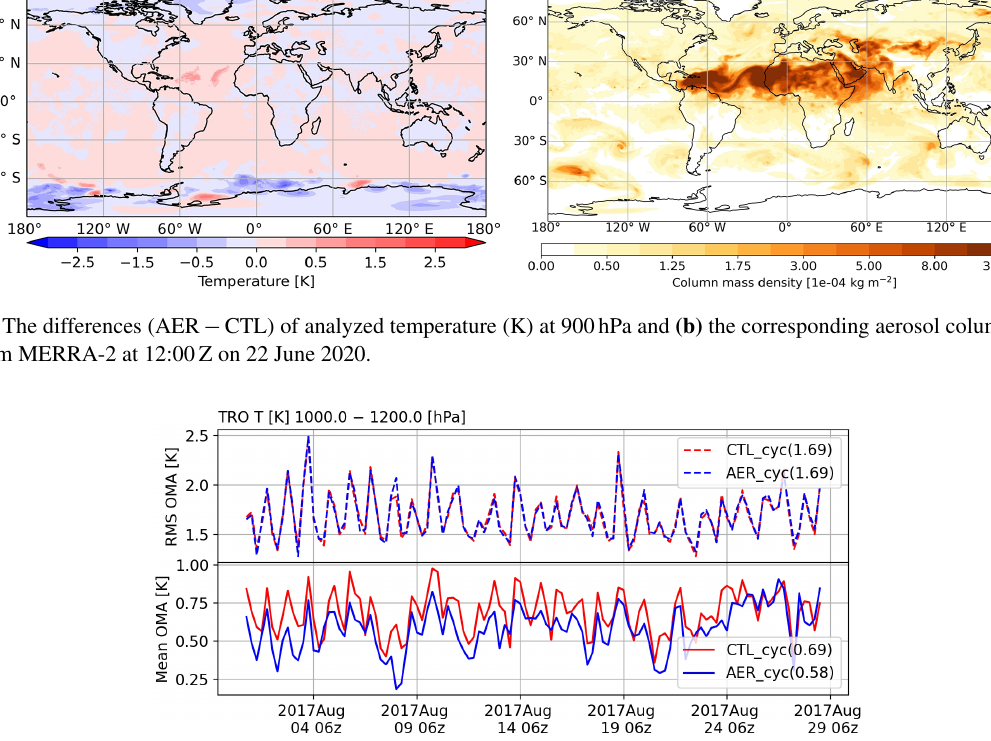
Figure 6. The comparison of the RMS and mean analysis departures (observation minus analysis, OMA) against in situ measurements (e.g., radiosonde) of temperature with pressure over 1000hPa at the tropical region (20 ◦ S–20 ◦ N) during 00:00Z on 1 August to 18:00Z on 28 August